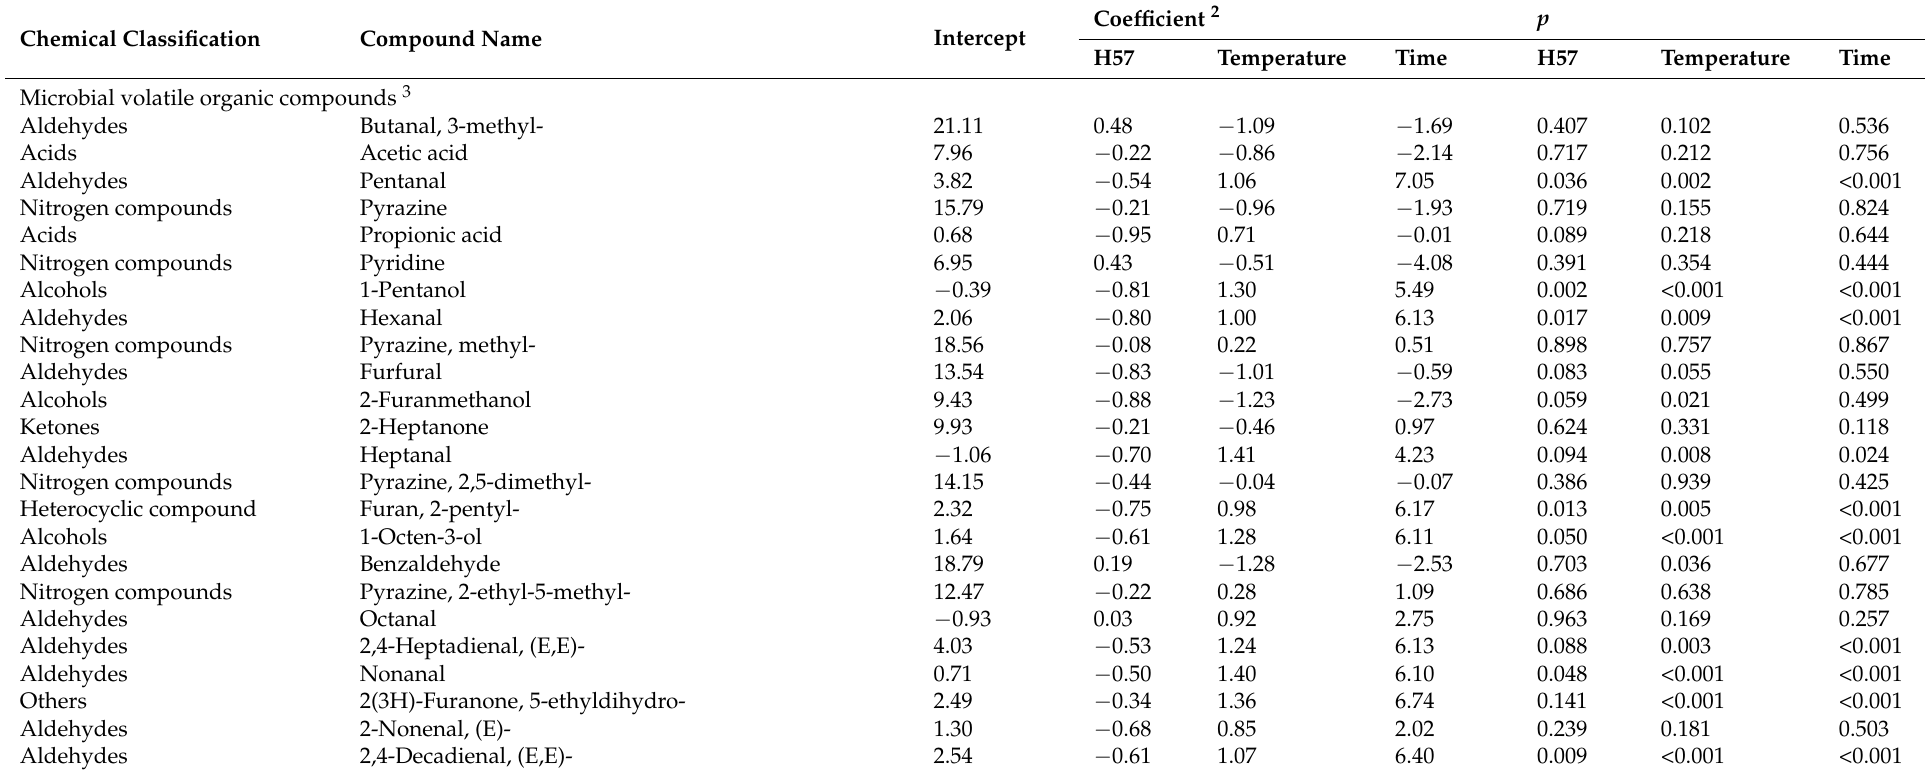
Table 1. Estimated regression coefficients of peak areas 1 of volatile organic compounds in the pellet treatments measured by the